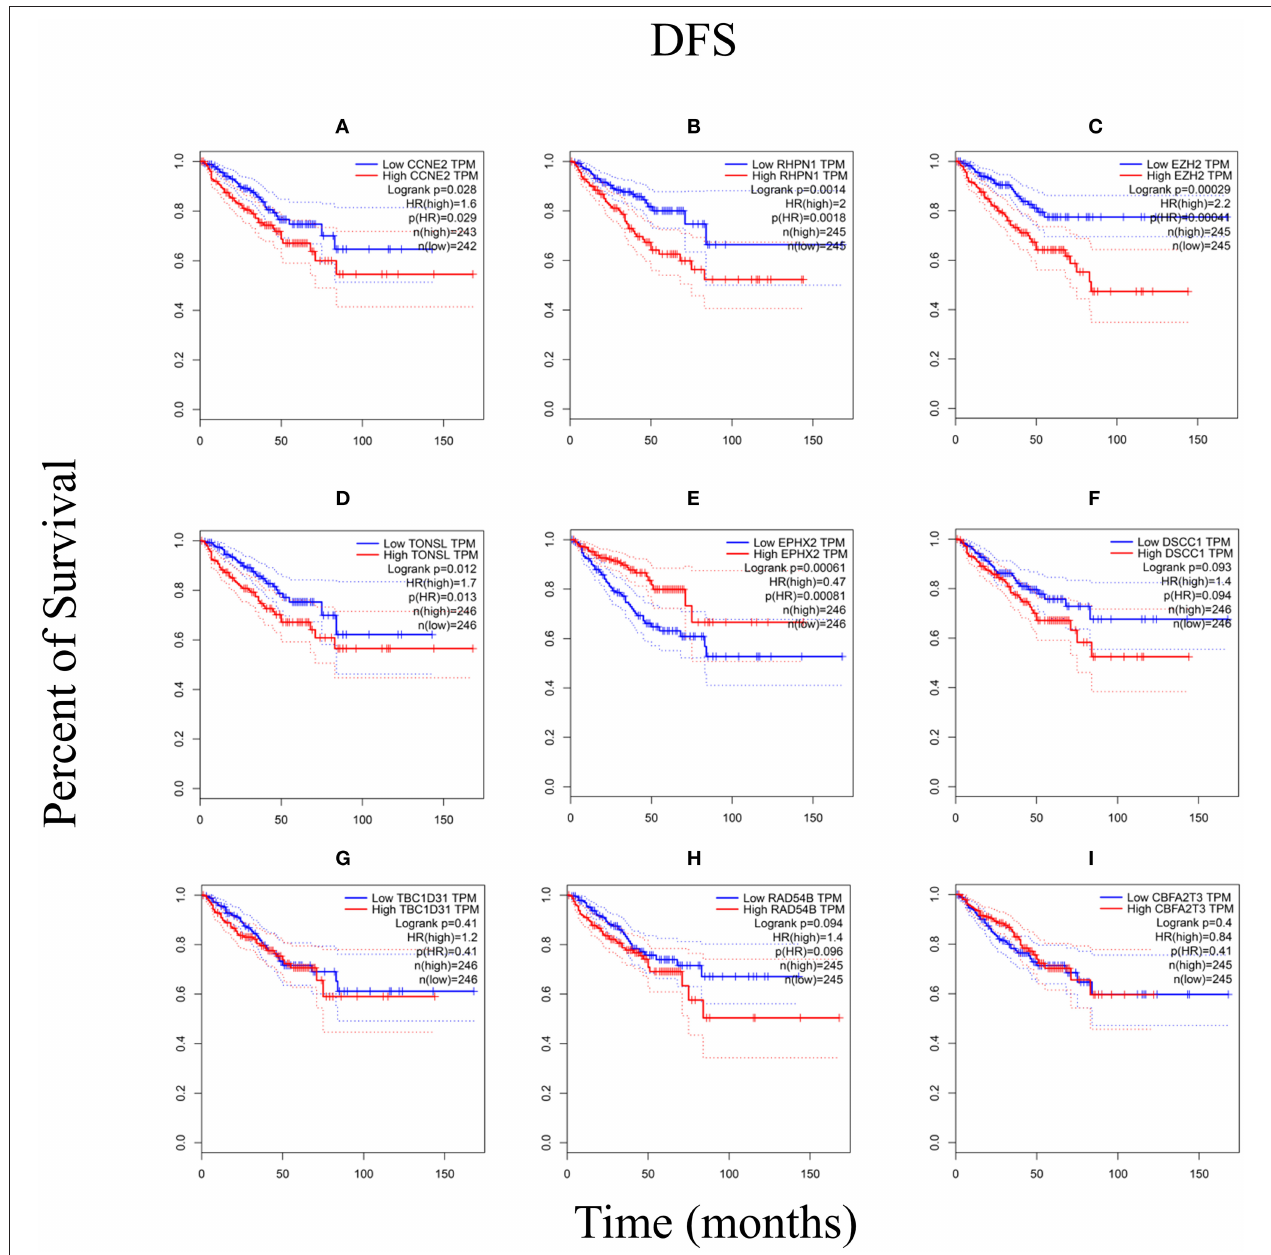
FIGURE 6 | The Kaplan–Meier analysis of nine genes. (A) CCNE2 , (B) RHPN1 , (C) EZH2 , (D) TONSL , (E) EPHX2 , (F) DSCC1 , (G) TBC1D31 , (H) RAD54B , and (I) CBFA2T3 . p < 0.05 was considered statistically different. DFS, disease-free survival. p < 0.001] and SLC7A4 [HR (high) = 0.44; p < 0.001], all hypermethylated in tumor samples ( n = 336) compared to normal tissue ( n = 49) ( Figures 8A , 9A ). There was a moderate inverse correlation between gene expression and methylation levels ( r > 0.4, p < 0.001; Figure 8B ). E2F pathway,” “Hallmark–E2F target,” and